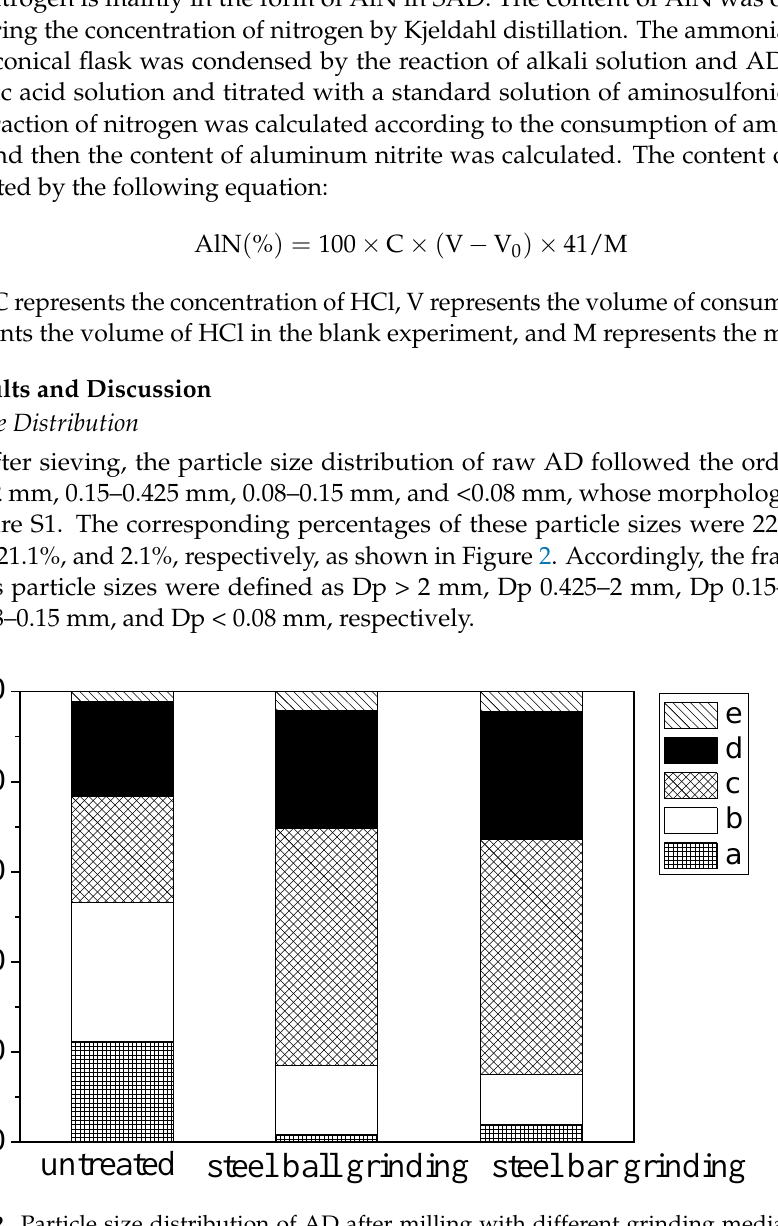
Figure 2. Particle size distribution of AD after milling with different grinding media (a: >2 mm, b: 0.425 – 2 mm, c: 0.15 – 0.425 mm, d: 0.08 – 0.15 mm, e: <0.08 mm). b: 0.425–2 mm, c: 0.15–0.425 mm, d: 0.08–0.15 mm, e: <0.08